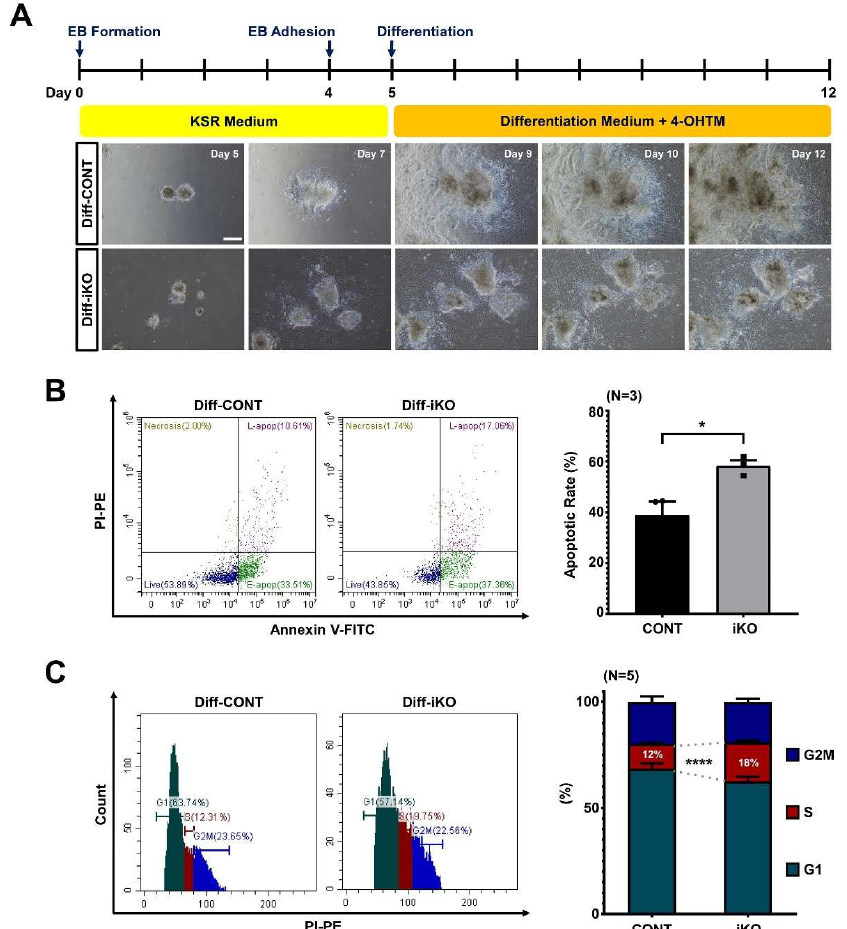
Figure 3. Ino80 depletion in differentiating ESCs causes extension of S-phase and apoptosis. ( A ) Schematic images showing differentiation protocol of differentiating ESCs, and representative images showing expansion of differentiating cells from for EBs. Images were captured at day 5, 7, 9, 10, and 12 after seeding same numbers of EBs on gelatin-coated dishes. Scale bar, 200 µ m. EBs, embryoid bodies. ( B ) Representative images of apoptosis analysis in Diff − CONT and Diff − iKO ESCs and quantification (N = 3). The difference in apoptosis rates between Diff − CONT and Diff − iKO ESCs is 19.57% on average. Diff − CONT ESCs, differentiating ESCs from CONT ESCs. Diff − iKO ESCs, differentiating ESCs from Ino80 iKO ESCs. ( C ) Representative cell cycle histogram of Diff − CONT and Diff − iKO ESCs and their percentages of G1, S, and G2/M phases (N = 5). Statistical significance was determined at a p-value lower than 0.05 (*) or 0.0001